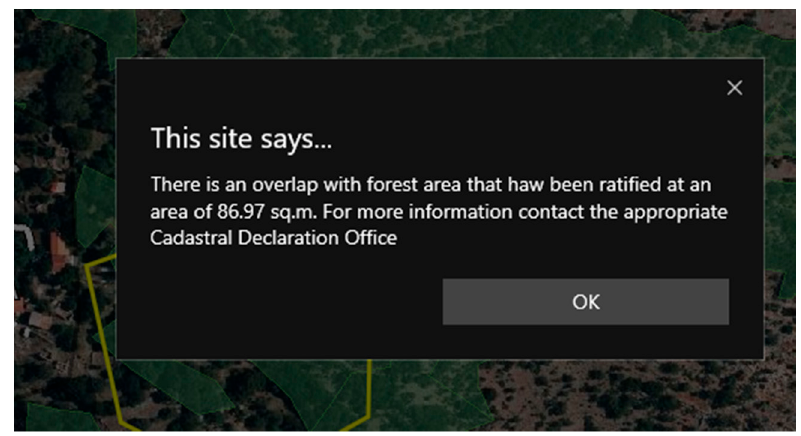
Figure 6. The system informs the user that there is an overlap with the final/ratified forest map. The user should visit the Cadastral declaration office.